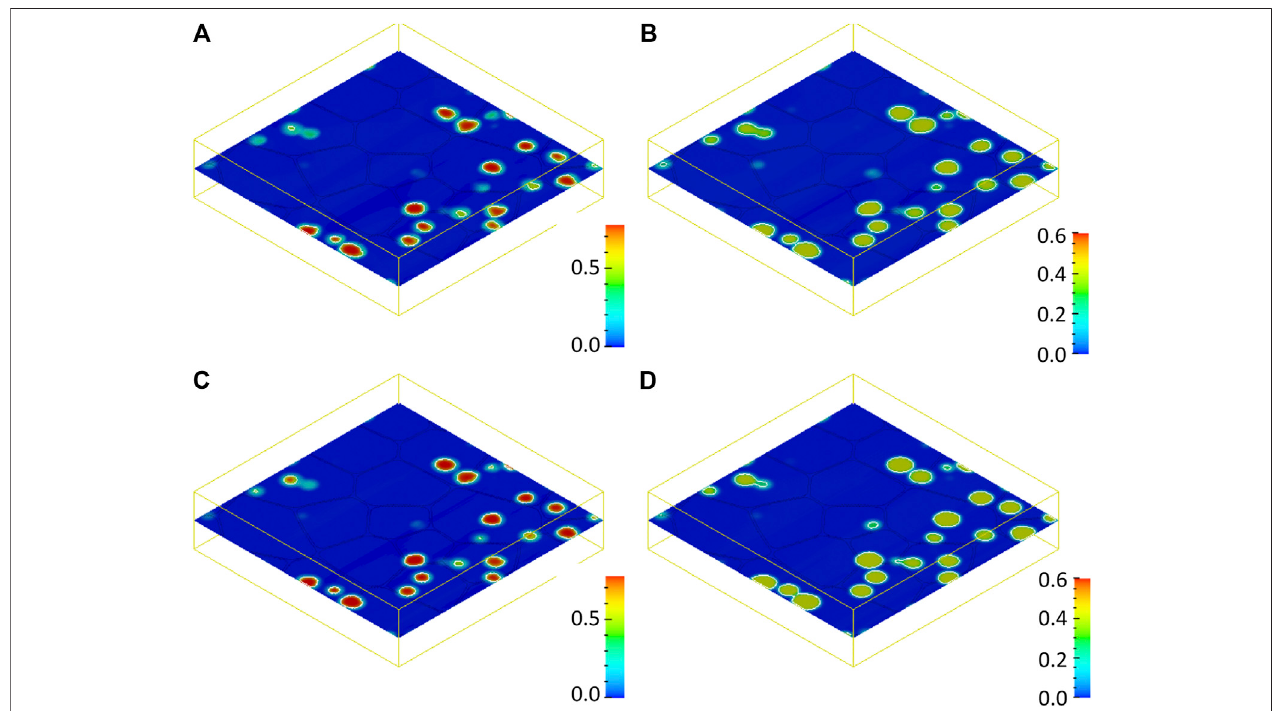
FIGURE 10 | Xe concentration distribution on the center plane S at time t (cid:2) 240h. (A) Xe rich ε 0 (cid:2) 0 . 1 under compressive stress state ε 33 (cid:2) − 0 . 05, (B) Xe rich ε (cid:2) 0 . 1undertensilestressstate ε 0 ε (cid:2) 0 . 33